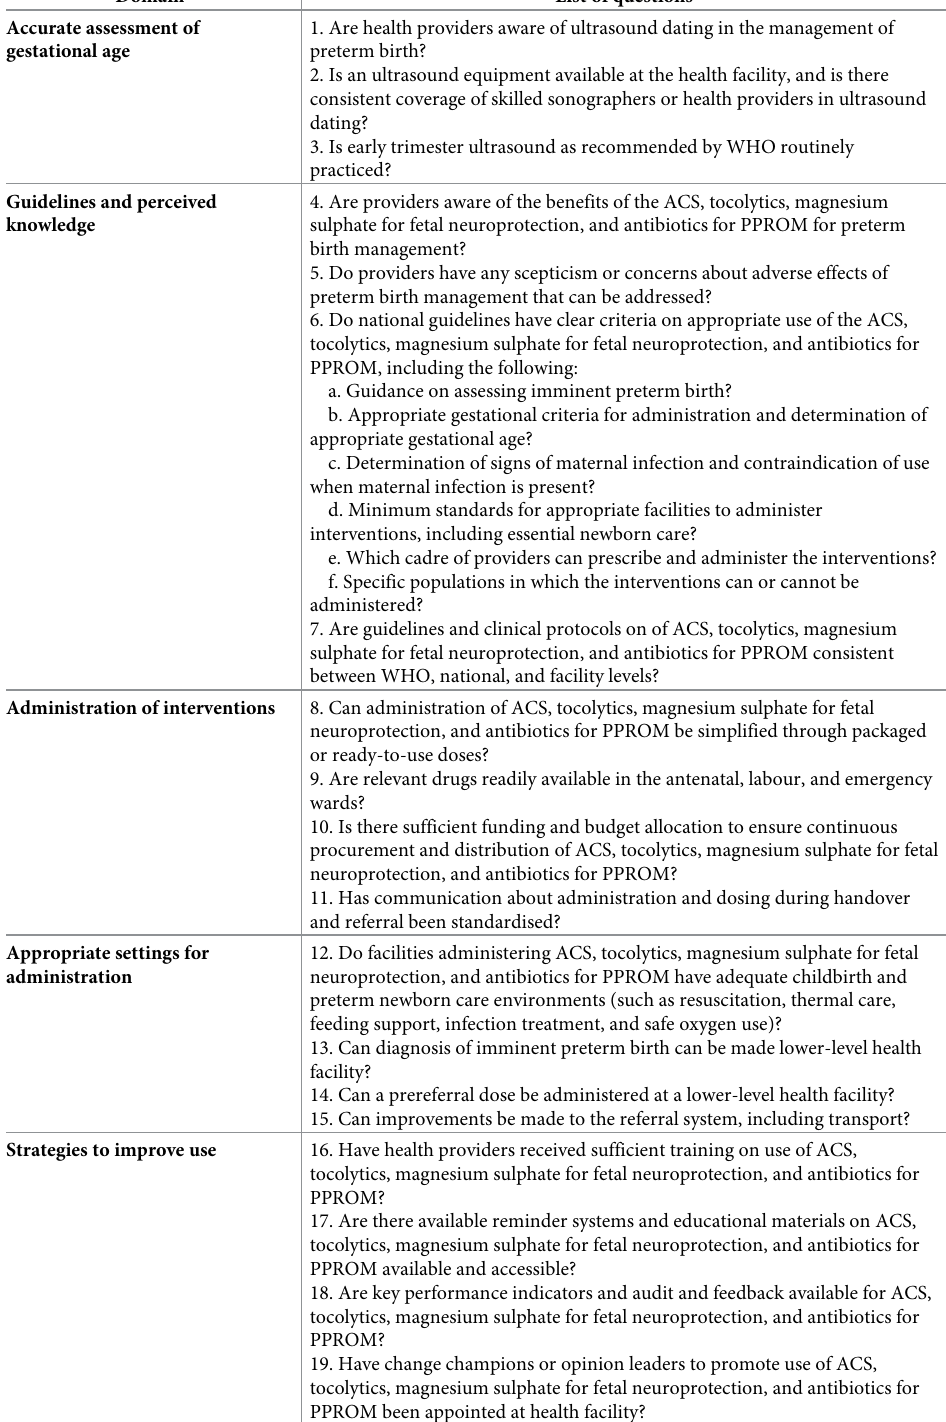
Table 4. Implications for practice. This table presents a list of questions derived from our findings and may help pro- gramme managers, policymakers, researchers, and other key stakeholders to identify and address factors that may affect implementation and scale-up of ACS, tocolytics, magnesium sulphate for fetal neuroprotection, and antibiotics for PPROM. Assessing the extent to which the barriers and facilitators identified in our review are potential